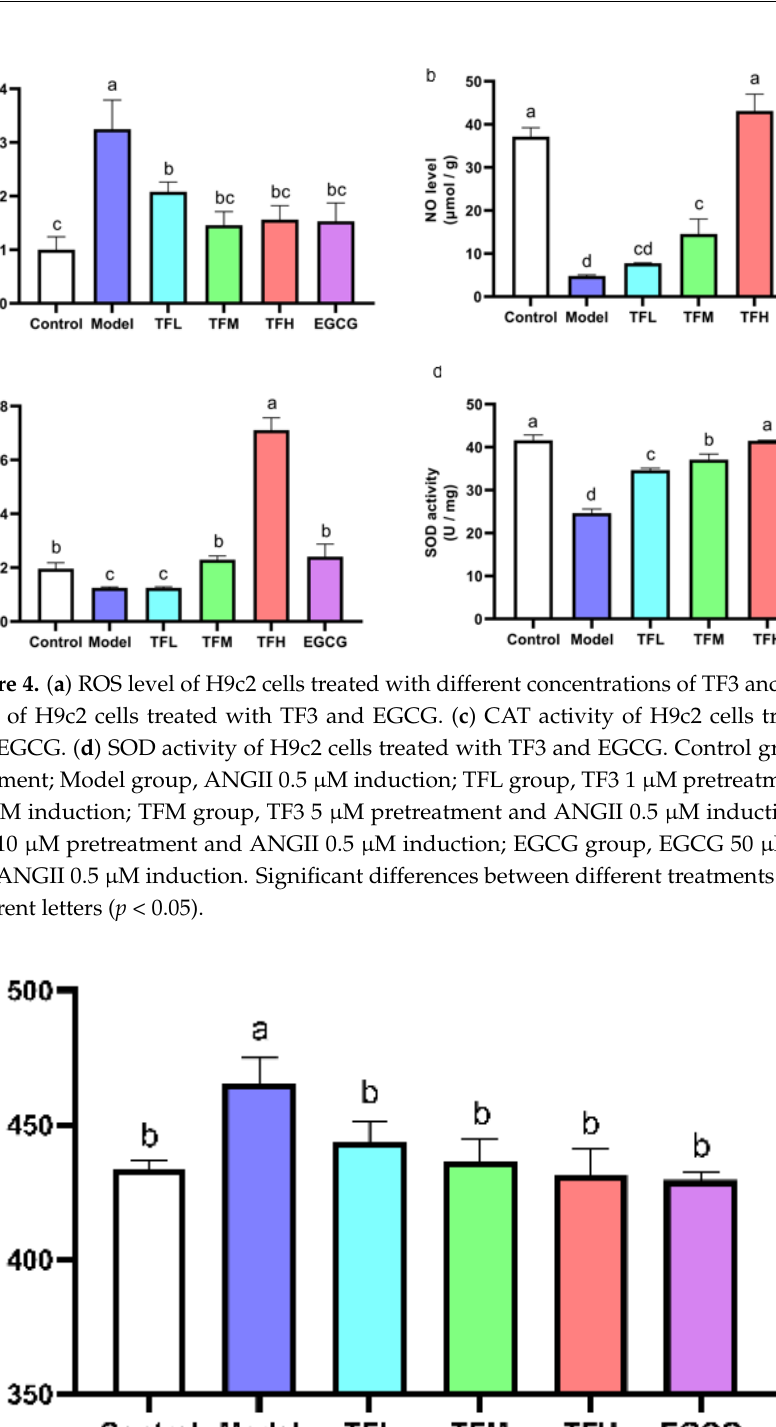
Figure 5. Fluo-4 fluorescence intensity of H9c2 cells treated with different concentrations of TF3 and EGCG. Control group, no ANGII treatment; Model group, ANGII 0.5 µ M induction; TFL group, TF3 1 µ M pretreatment and ANGII 0.5 µ M induction; TFM group, TF3 5 µ M pretreatment and ANGII 0.5 µ M induction; TFH group, TF3 10 µ M pretreatment and ANGII 0.5 µ M induction; EGCG group, EGCG 50 µ M pretreatment and ANGII 0.5 µ M induction. Significant differences between different treatments were shown by different letters ( p <